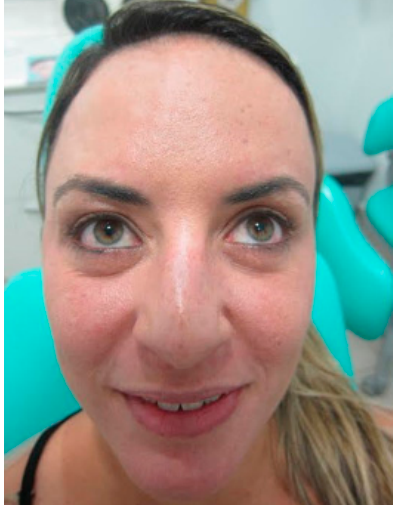
Figure 7. After 14 days, contraction of the frontal muscle was corrected.